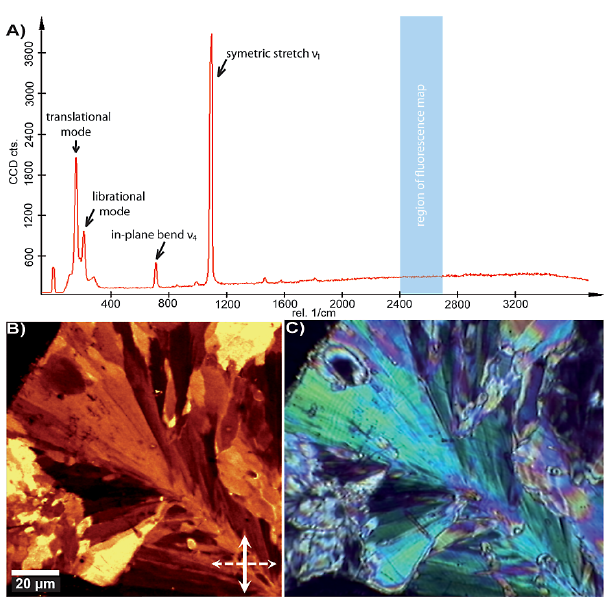
Fig. 3. Raman spectra, Raman intensity map and PLM image illus- trating the crystallographic orientation within the fan system. (A) Raman spectra of P. lutea skeleton sample showing the character- istic peaks for aragonite. Highlighted in blue is the spectral region used to derive the fluorescence maps. (B) Relative change in crys- tallographic orientation derived from the Raman peak at 1085cm − 1 resembles the fiber orientation shown in the PLM image (C) . Solid arrow in (B) indicates the laser polarization plane and dashed arrow the orientation of the